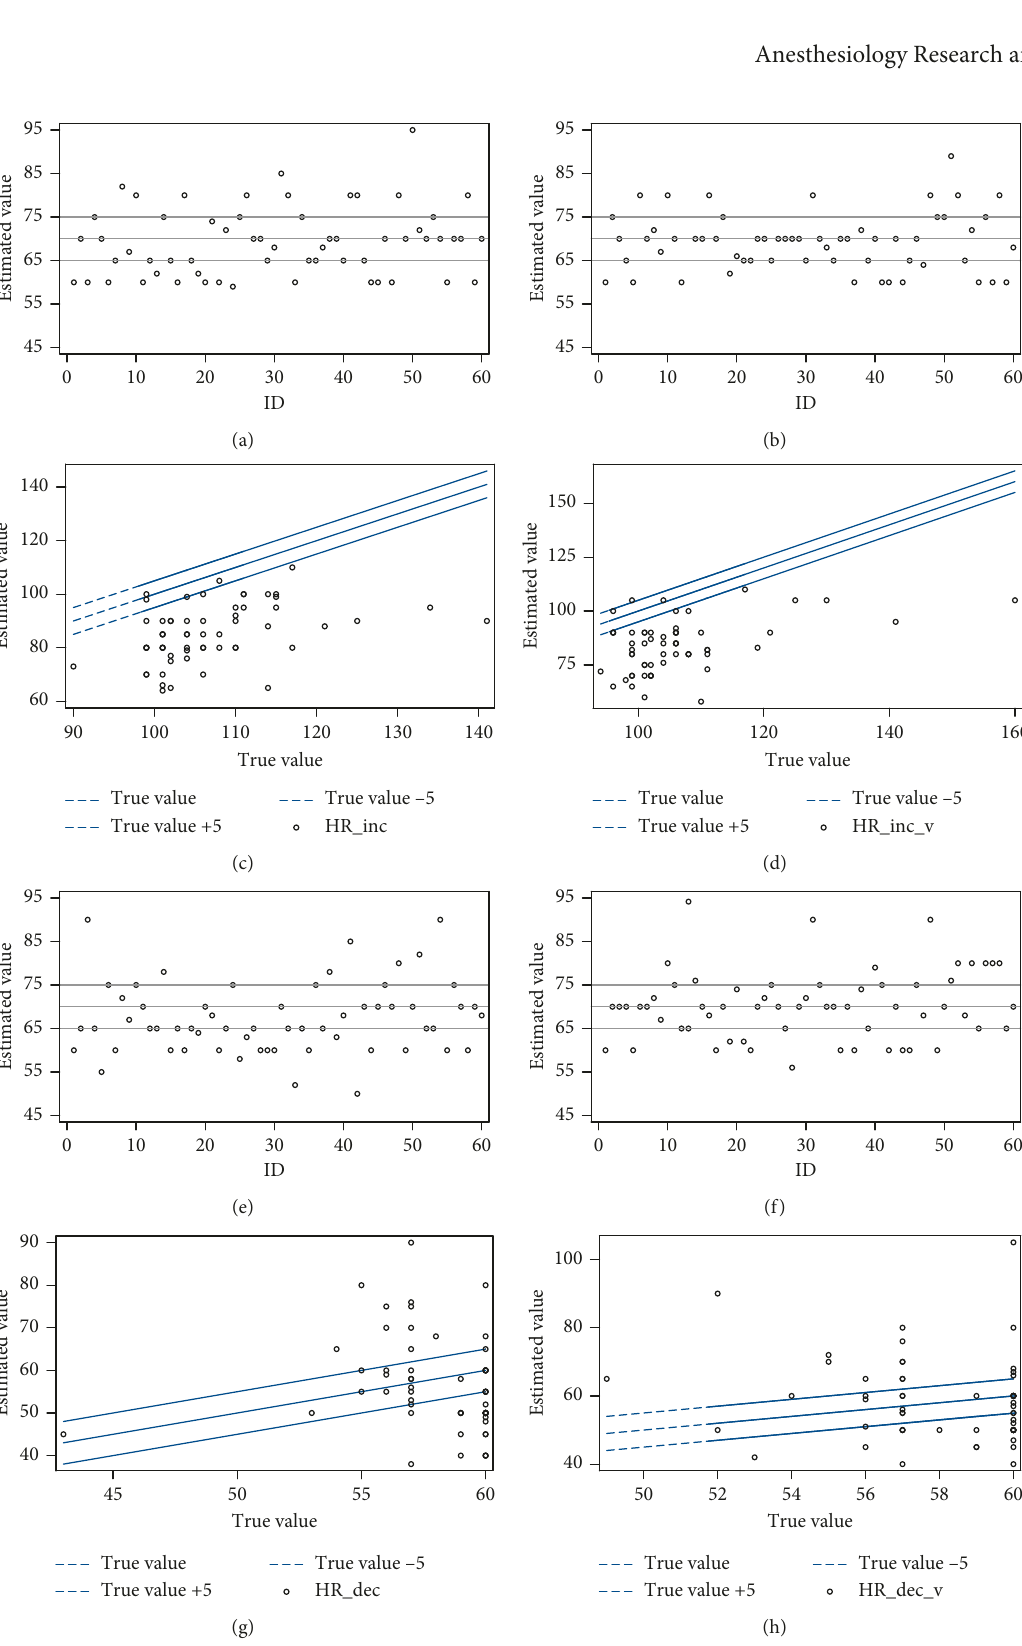
Figure 1: Heart rate estimation under different recording settings. Each dot represents one individual estimation, and the lines represent the true values and the acceptable correct estimating values (true value ± 5). (a) Scenario A first attempt. (b) Scenario C first attempt. (c) Scenario B after A. (d) Scenario B after C. (e) Scenario A second attempt. (f) Scenario C second attempt. (g) Scenario D after A. (h) Scenario D after